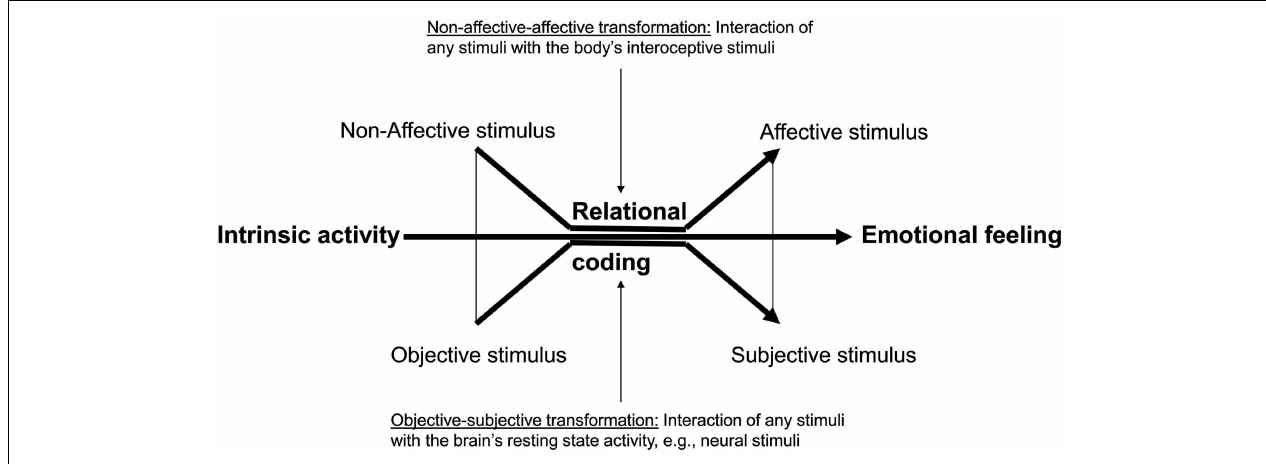
non-affective and objective.That rest-stimulus interaction leads to the assignment of affect and subjectivity to the stimulus resulting in emotional